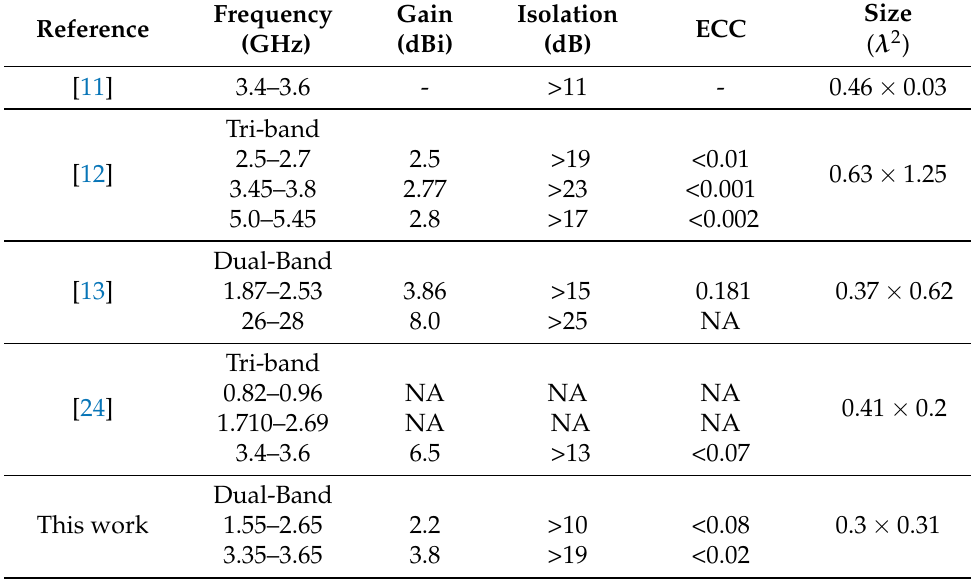
Figure 10. Measured and simulated radiation patterns. ( a ) E-plane at 1.8 GHz; ( b ) H-plane at 1.8 GHz; ( c ) E-plane at 2.4 GHz; ( d ) H-plane at 2.4 GHz; ( e ) E-plane at 3.5 GHz; ( f ) H-plane at 3.5 GHz. Table 2. Comparison with previous